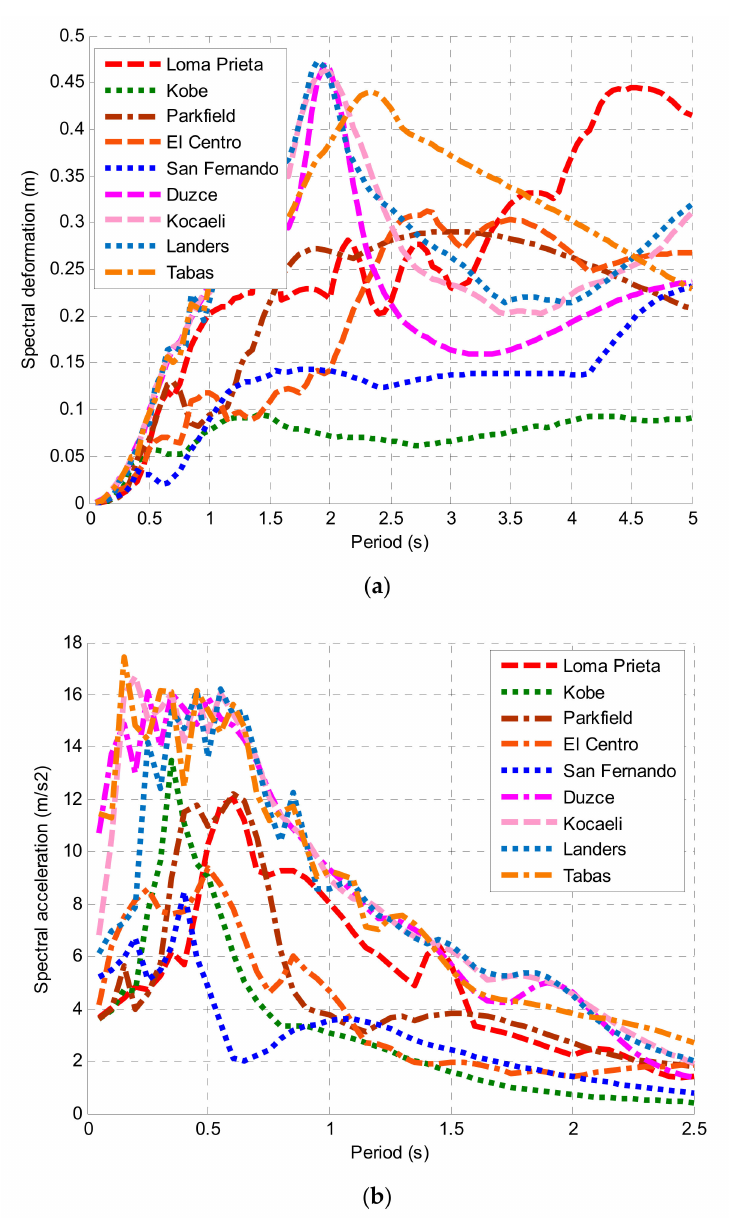
Figure 2. Displacement response spectra ( a ) and acceleration response spectra ( b ) of di ff erent earthquakes (structural damping: